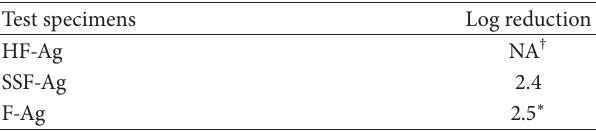
Table 2: Log reduction of Pseudomonas aeruginosa (PAO1) in silver containing dressings in comparison to their